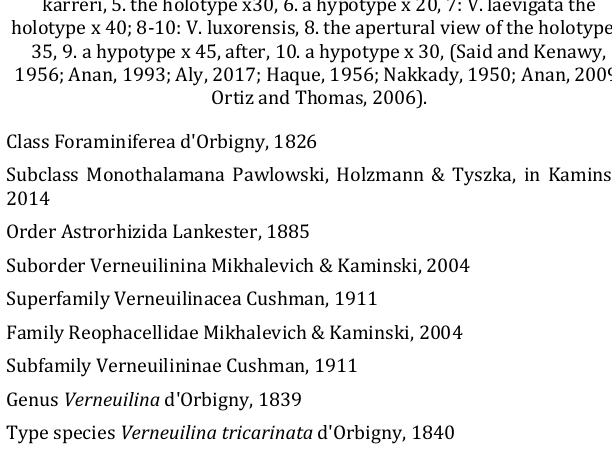
Figure 2: Stratigraphic positions of the Verneuilina members : 1. V. iraqensis Anan, n. sp. (Late Campanian), 2, 3. V. aegyptiaca Said and Kenawy (Maastrichtian-Paleocene), 4. V. karreri Said and Kenawy (Maastrichtian-Paleocene) , 5. V. laevigata Haque (Paleocene), 6. V. jordanica Anan, n. sp. (Ypresian), 7, 8. V. luxorensis Nakkady (Ypresian).